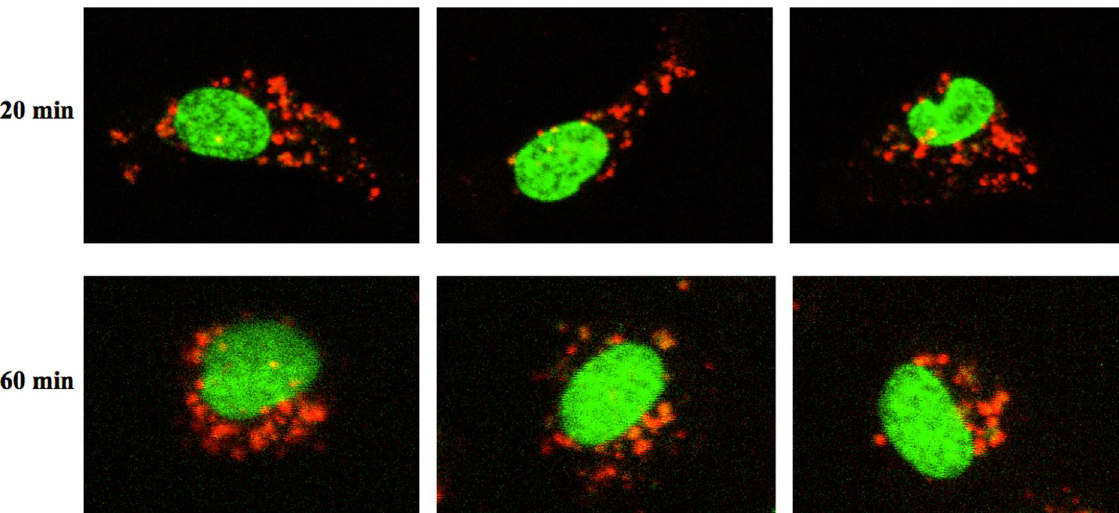
Figure 3. Live confocal microscopy visualizing STBEV uptake and intracellular transport. Uptake of PKH- labelled STBEVs into HCAECs was followed by live confocal microscopy. Three representative cells are shown after 20 and 60 min of incubation. After 20 min the STBEVs are clearly internalised and widely distributed in the cell cytoplasm. After 60 min the STBEVs appear to be closer to the cell nuclei. Cell nuclei are pseudocolored in green, and PKH-labelled STBEVs in red. The figures are from live imaging, explaining the lower intensity at 60 minutes due to